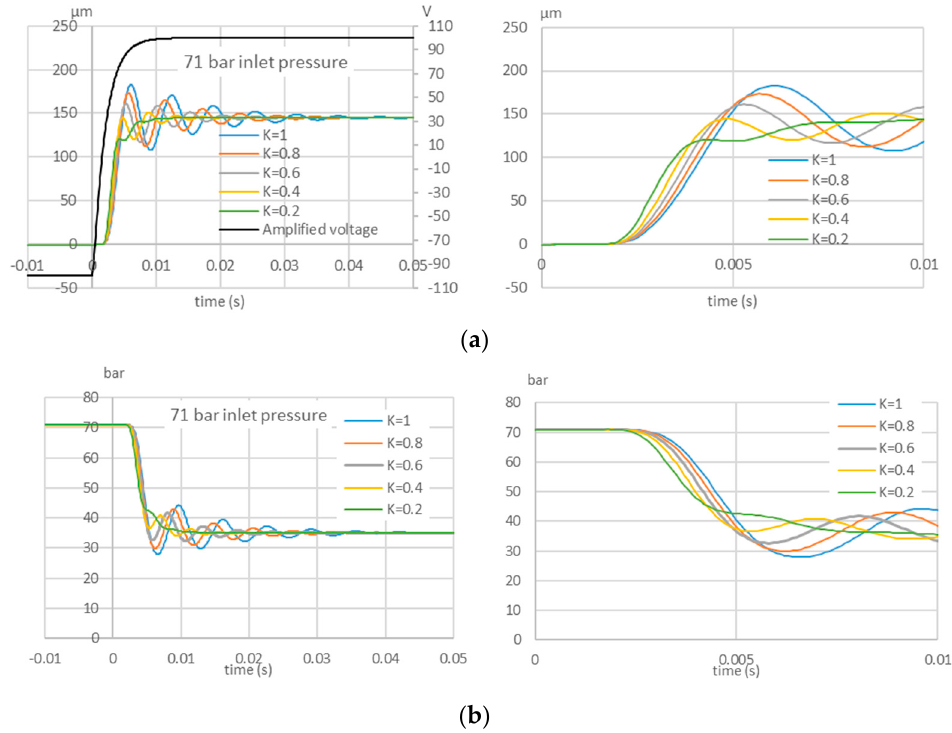
Figure 13. Ring bender displacement with enlargement ( a ) and pressure at point 7 with enlargement ( b ), simulated for an amplified voltage from − 100 V to +100 V and for different values of the mass of the moving parts: m = K m 0 , with K = 1, 0.8, 0.6, 0.4, 0.2 (supply pressure = 71 bar, D = 0.6 D 0 and L = 0.6 L 0 ).